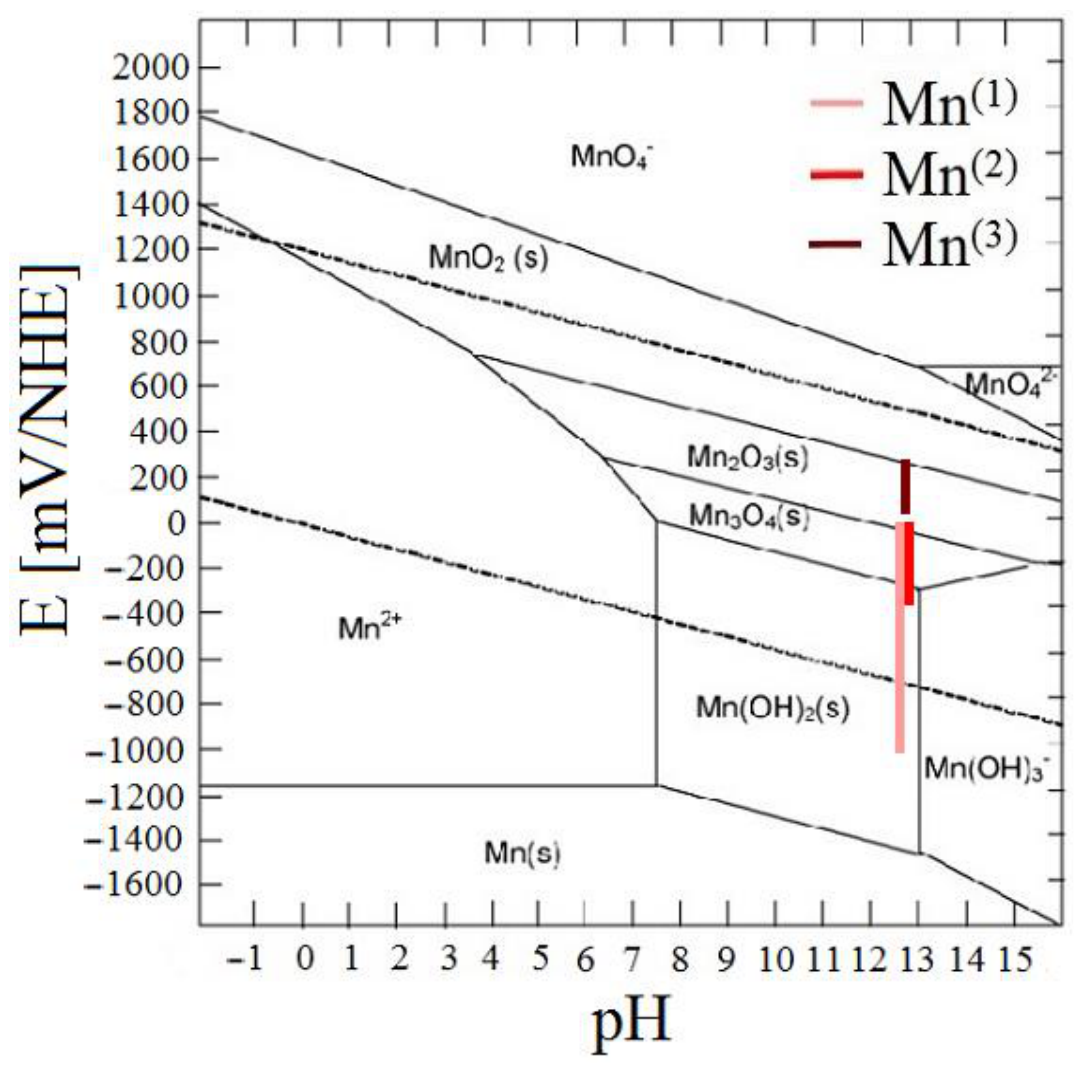
Figure 6. E-pH (equilibrium) diagram of manganese, marked areas signify stability ranges for indi- vidual phases E corr of HDG in simulated concrete pore solutions with KMnO 4 [88]. individual phases E corr of HDG in simulated concrete pore solutions with KMnO 4